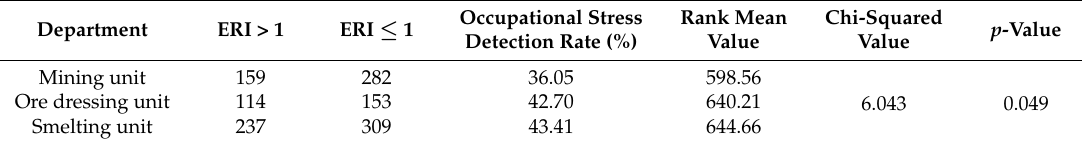
Table 3. Comparison of occupational stress among copper and nickel miners working in mining, ore dressing, and smelting